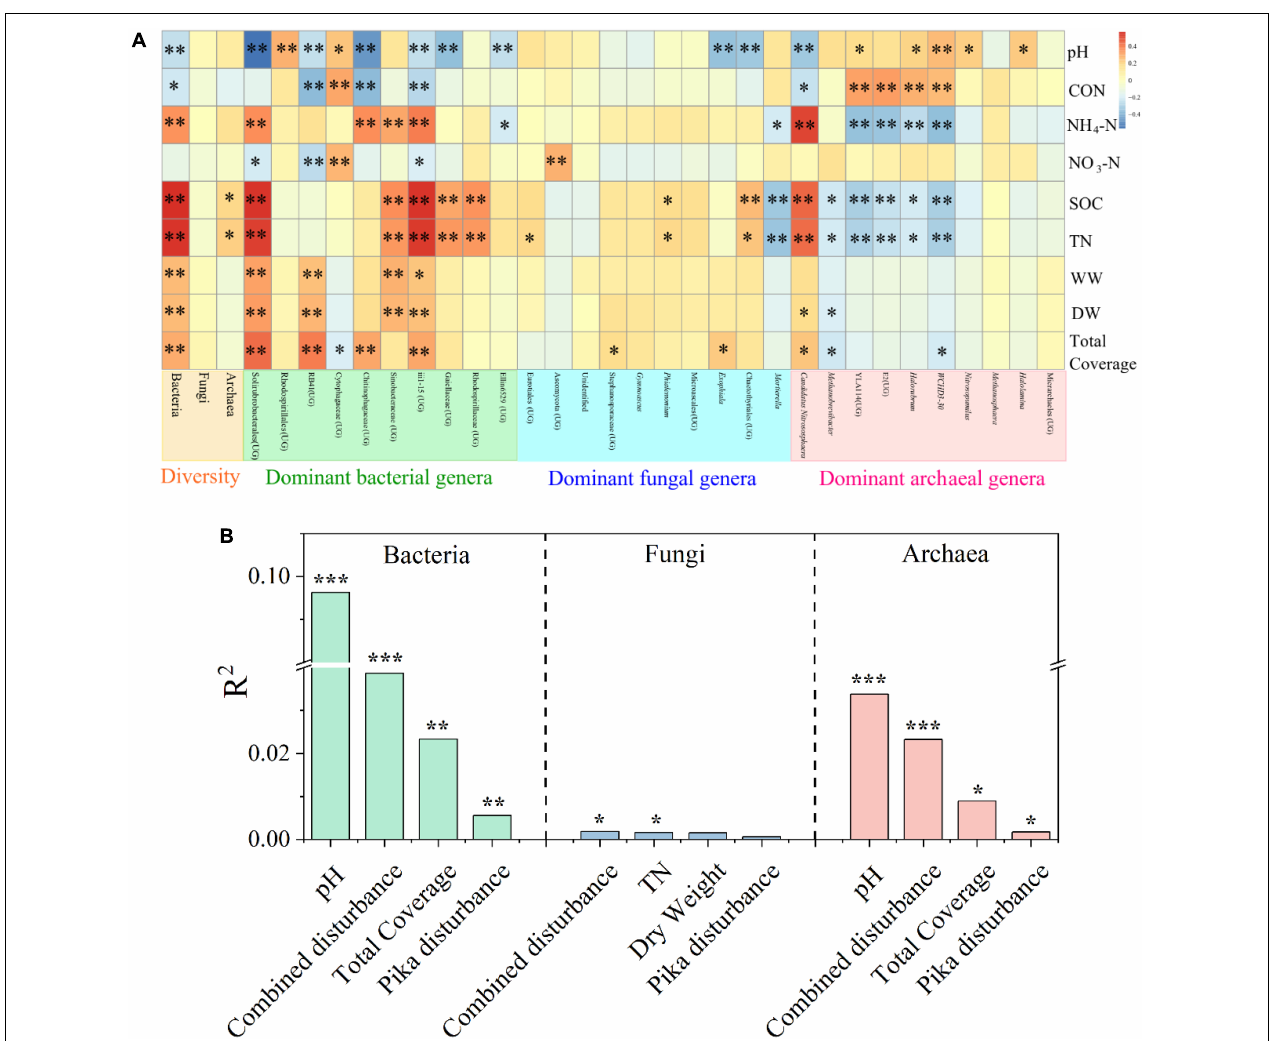
FIGURE 4 | Heatmap showing the correlation coefficients between environmental factors and the α diversity and main genera (the top ten genera of relative abundance) of bacteria, fungi, and archaea based on Spearman’s rank correlation test (A) . Multiple regression on distance matrices (MRM) was used to estimate the relative proportions of variance explained by driving factors (top 4) in the communities (B) . CON, conductivity; NH 4 -N, ammonium nitrogen; NO 3 -N, nitrate-nitrogen; SOC, soil organic carbon; TN, total nitrogen; WW, wet weight; DW, dry weight; UG, unidentified genus. Significant indicator by ∗ P < 0.05, ∗∗ P < 0.01, and ∗∗∗ P <